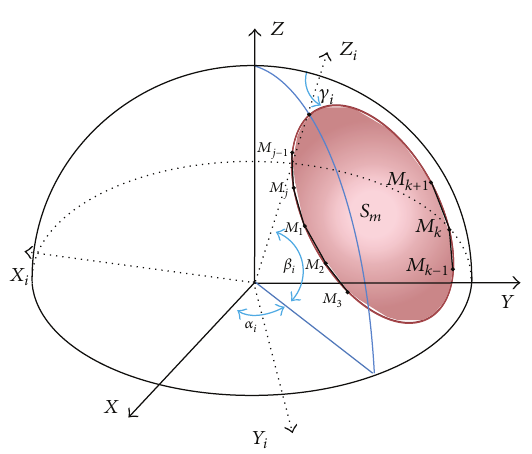
Figure 6: Task attitude constraints on sphere surface.